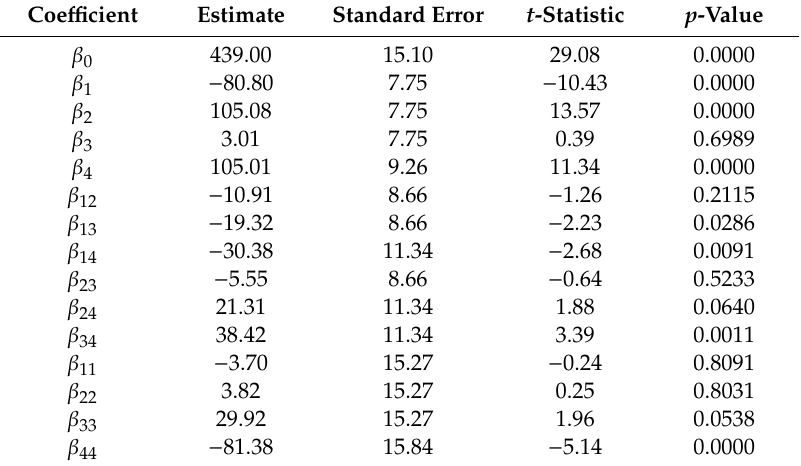
Table 3. Results of estimating 15 regression coe ffi cients using the method of least